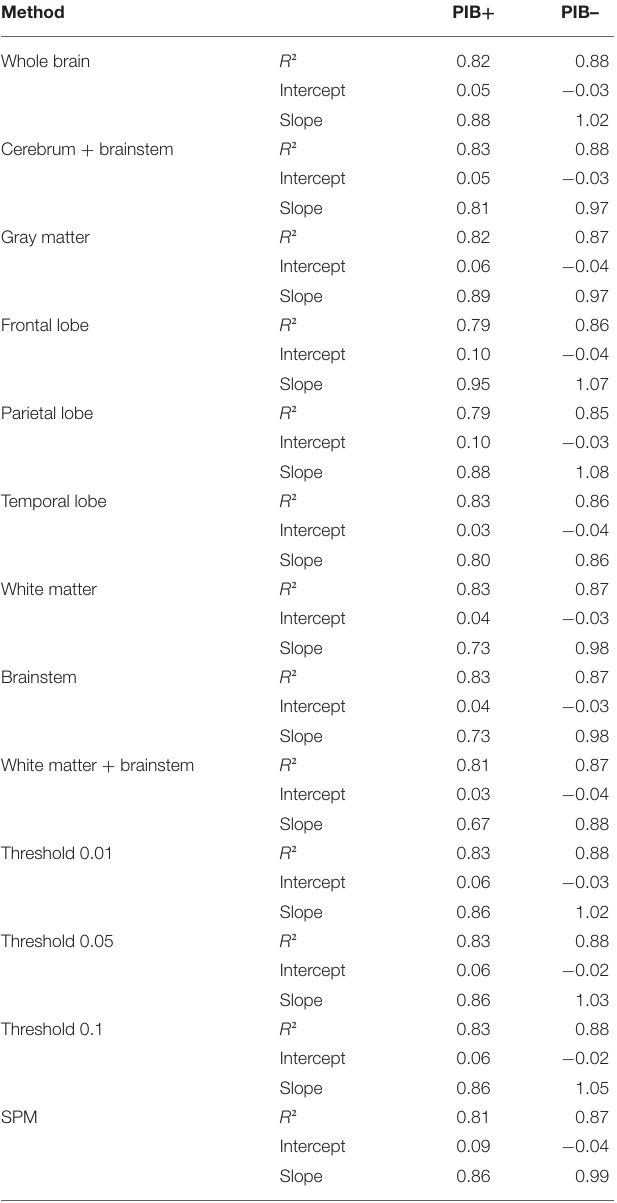
TABLE 1 | Results from the general linear model comparing BP SRTM ND and BP SRTM 2 ND from different methods. Method PIB